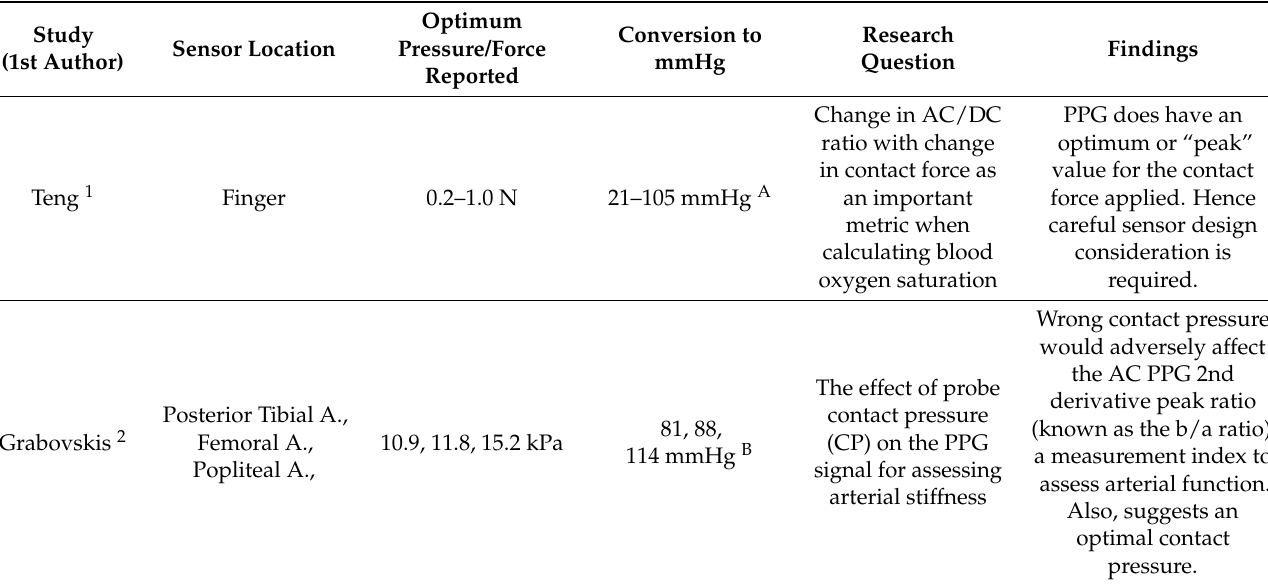
Table 1. Previous PPG force studies performed assessing sensor contact force to the quality of measurements made using PPG. A Assumption here is that the PPG probe was no larger than the force-sensing probe reported in the study; B Straight conversion kPa to mmHg (kPa times 7.501); C Straight Conversion hPa to mmhg (hPa divided by 1.333); D Same as assumption in A , but also assuming researchers used the smallest version of the sensor reported available to account for the nature of the study (paediatrics, index finger). 1 [4]; 2 [5]; 3 [6]; 4 [7]; 5 [8]; 6